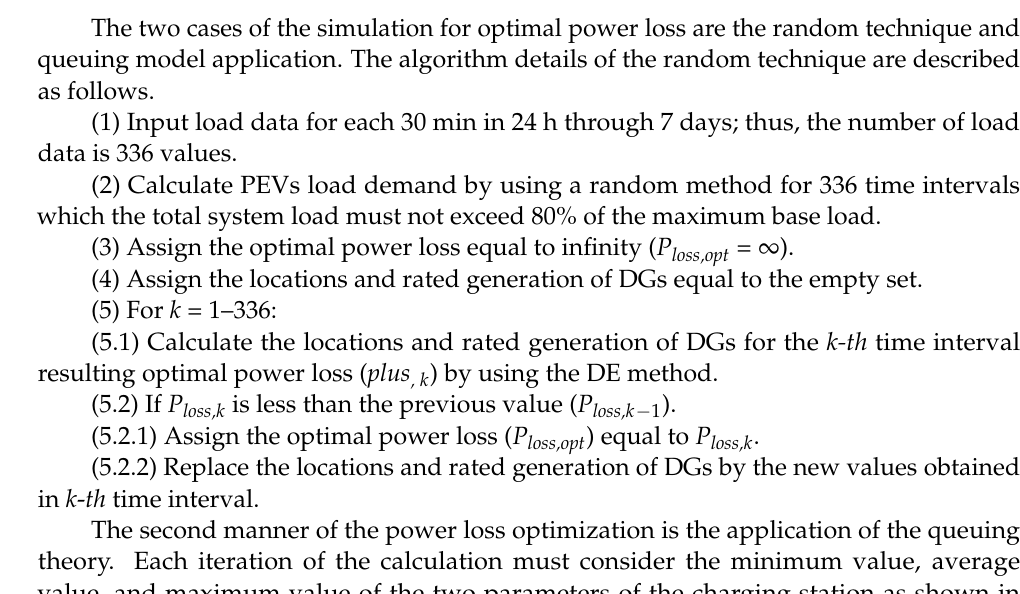
Figure 6. The base load curve of the test system.